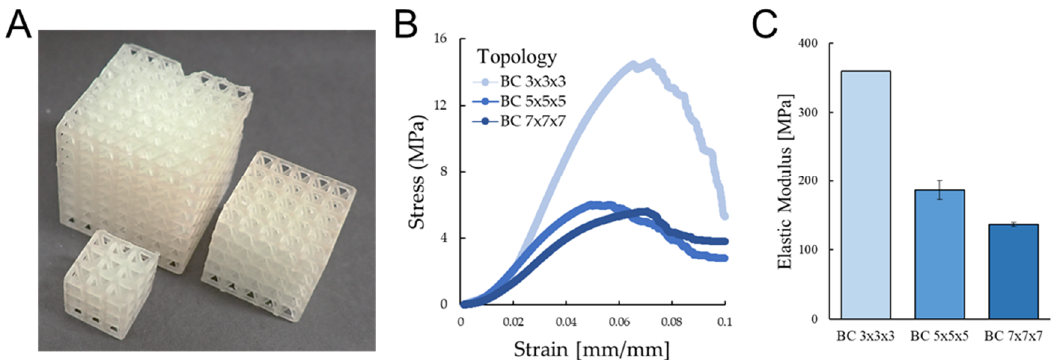
Figure 7. Rescaling of BC cube lattice showing fabrications for ( A ) BC cube 3 × 3 × 3, BC cube 5 × 5 ×